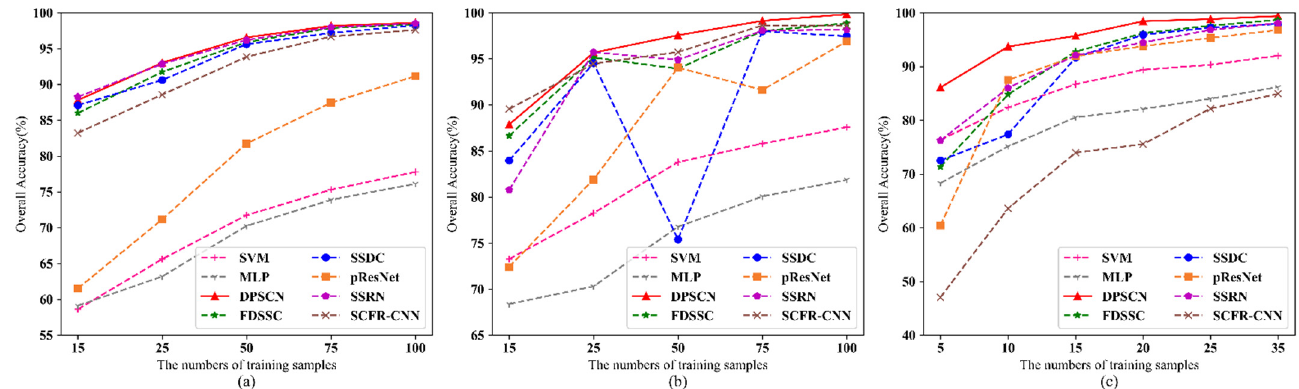
PU data set. Figure 8. Overall accuracy (OA) of different models with different training samples. ( a ) IP data set. ( b ) KSC data set. ( c )